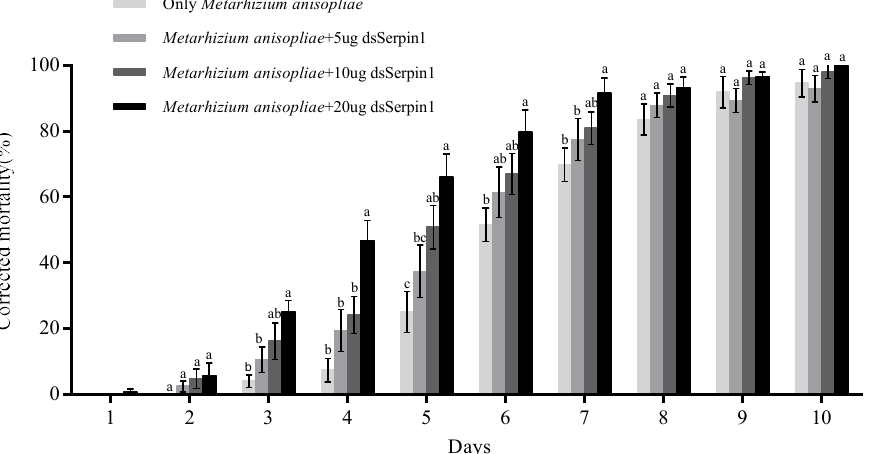
Figure 3. Corrected mortality of L. m. manilensis showing the effects of feeding different doses of dsSerpin1 with M. anisopliae for up to 10 days. (There were differences between a–c representatives and other